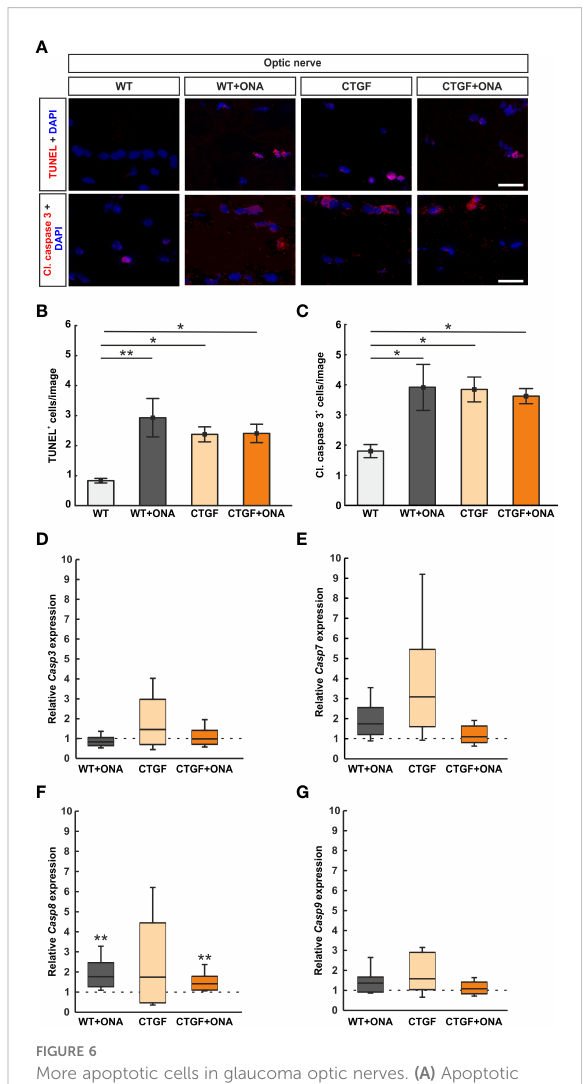
FIGURE 6 More apoptotic cells in glaucoma optic nerves. (A) Apoptotic cells were labelled with TUNEL (red) and an antibody against anti-cleaved caspase 3 (red) on optic nerve sections, while cell nuclei were stained with DAPI (blue). (B) The number of TUNEL + cells signi fi cantly increased in WT+ONA, CTGF, and CTGF+ONA optic nerves in comparison to WT mice. (C) The number of cleaved caspase 3 + cells was elevated in WT+ONA, CTGF, and CTGF+ONA mice compared to WT. (D) The mRNA expression levels of Casp3 were not altered. (E) Casp7 mRNA expression levels did not differ between groups. (F) The mRNA expression levels of Casp8 were signi fi cantly upregulated in WT+ONA and CTGF+ONA animals. In CTGF optic nerves, the Casp8 mRNA levels were not altered. (G) Casp9 mRNA expression levels were equivalent in all groups. Values are mean ± SEM for immunohistology and median ± quartile ± minimum/maximum for RT-qPCR. The dotted lines in (C – F) represent the relative expression of the WT group. *p<0.05 and **p<0.01 vs . WT. Scale bars: 20